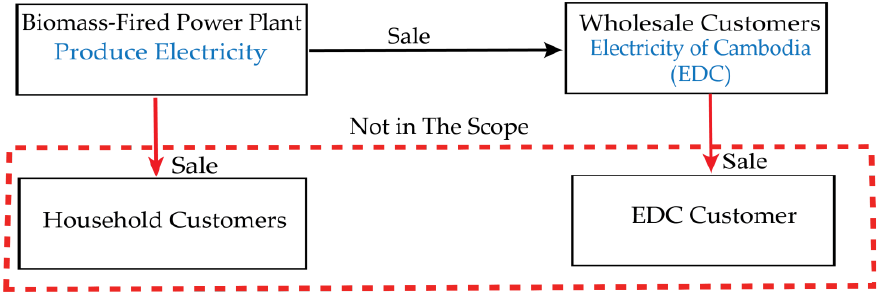
Figure 1. Block diagram of business model.